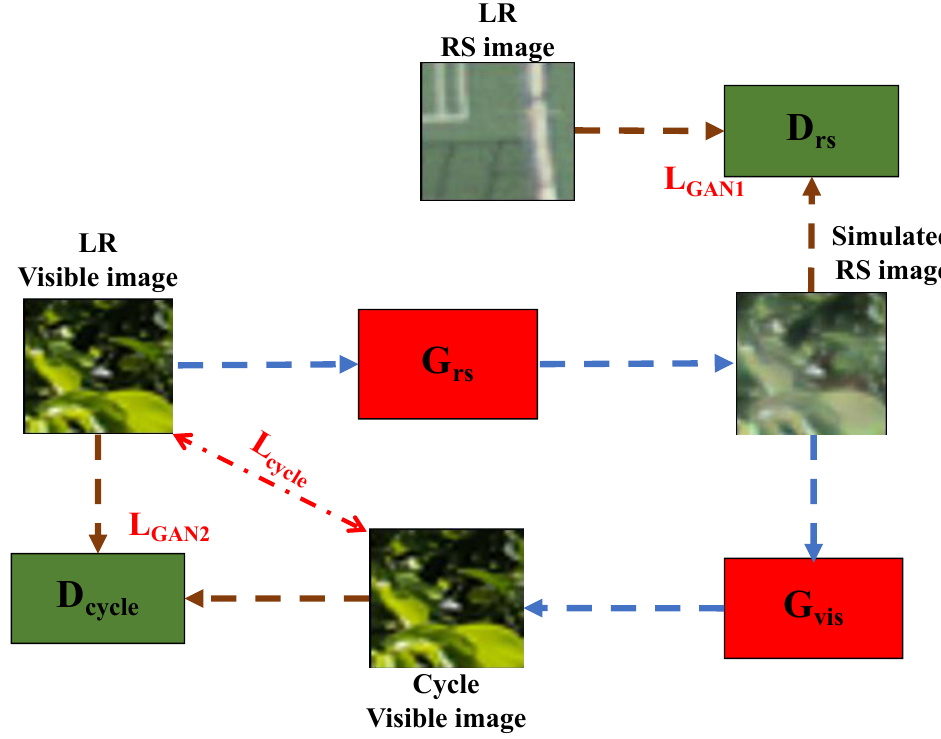
Figure 2. The architecture of CycleGAN in